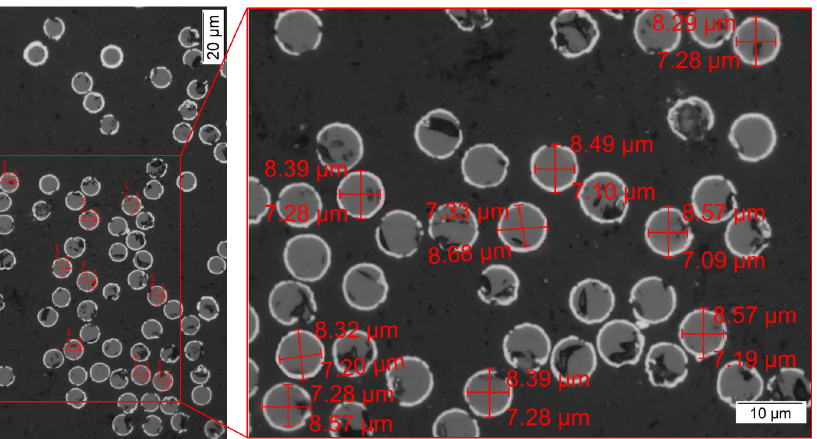
Figure 2. Cross-sectional analysis for the determination of fiber diameter and coating thickness— micrograph of sample 01-01.